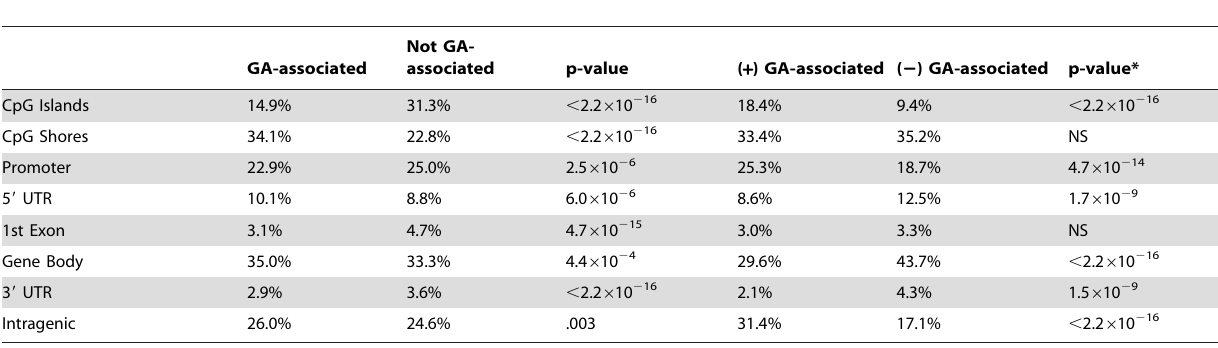
Table 3. Enrichment analysis to examine whether there is a an enrichment in certain regions that associated with GA, or whether there is an enrichment of a certain direction of a t-statistic for associated CpG